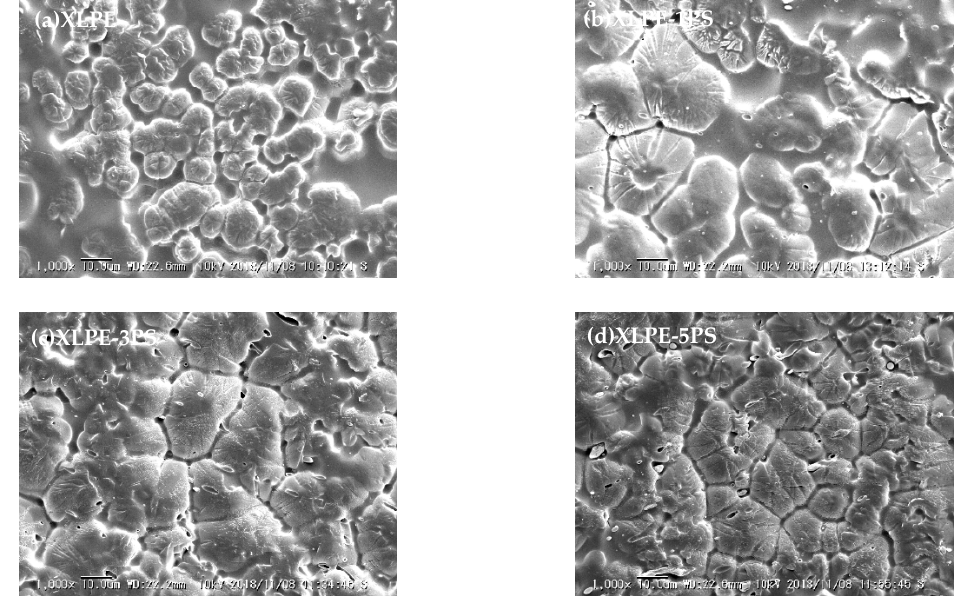
Figure 6. The etched surface morphology of samples by SEM. ( a ) XLPE, ( b ) XLPE-1PS, ( c ) XLPE-3PS, ( d ) XLPE-5PS.